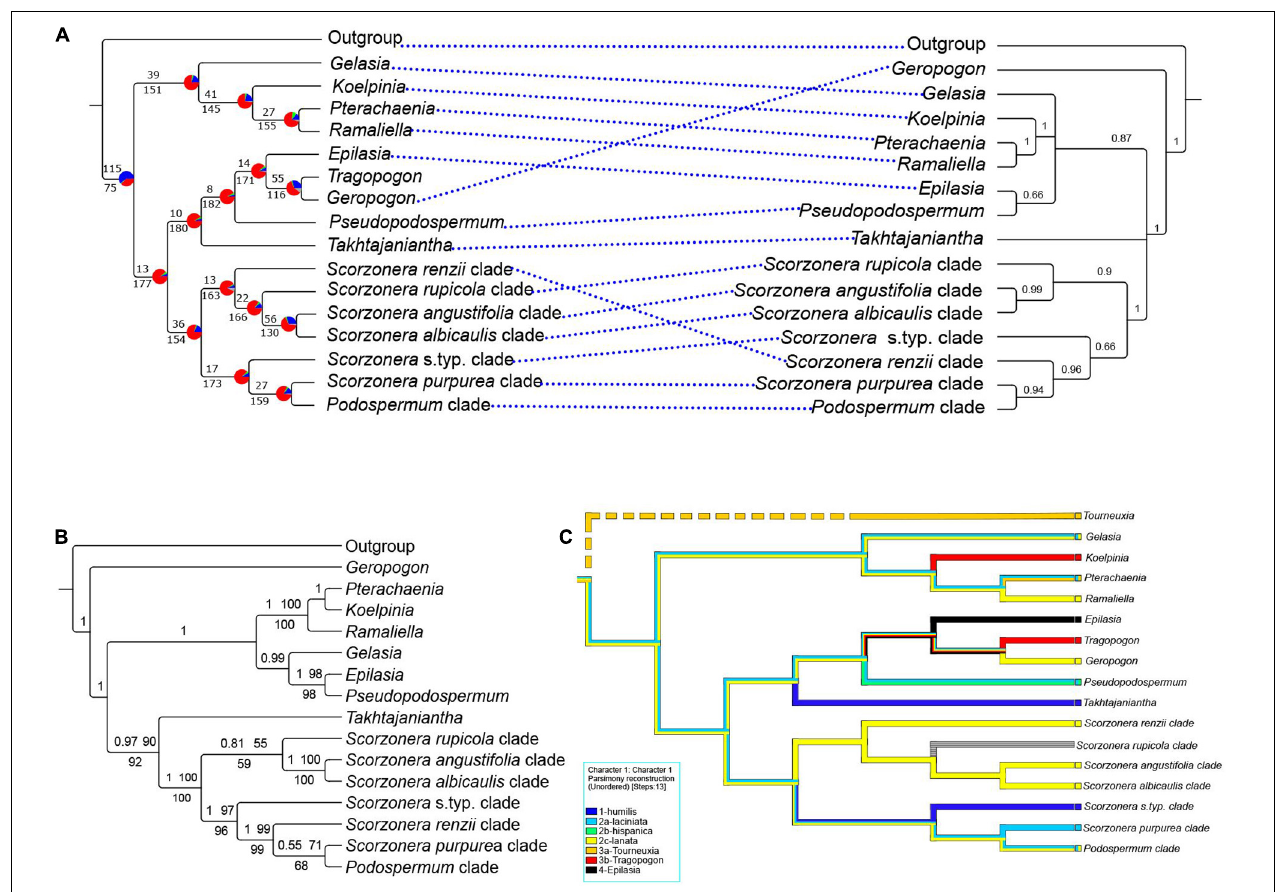
FIGURE 4 | (A) Mirrored nuclear ELS coalescent backbone (left) and plastome CDS coalescent trees (right); the ELS tree with a summary of concordant and discordant gene trees. For each branch, the top number indicates the number of concordant gene trees and the bottom numbers those of conflicting gene trees. The pie charts indicate the proportion of gene trees that support that clade (blue), the proportion that supports the main alternative for that clade (green), the proportion that supports all other topologies (red) or the proportion of uninformative gene trees for that clade (gray); the plastome CDS tree with local posterior probability (LPP) support values. (B) Backbone topology of plastome CDS concatenated species tree, posterior probabilities (PP) of Bayesian analysis and bootstrap values of ML no-partitioned analysis (BS-NP) above the branches and bootstrap values of ML partitioned analysis (BS-P) below the branches. (C) Parsimony ancestral character state reconstruction on the nuclear ELS coalescent backbone tree for the seven pollen types of the Scorzonerinae identified by Blackmore (1982). The numerals in the state designations indicate the four hypothetical principal evolutionary lines of pollen types and the letters the subordinate lines according to Blackmore (1982; Figure 7 ). Tourneuxia is included as a putative early diverging lineage (indicated by the broken line) following Zaika et al. (2020). Except in the ELS tree of A, branches with less than 50% bootstraps (BS-NP and BS-P), 0.5 PP and 0.5 LPP are